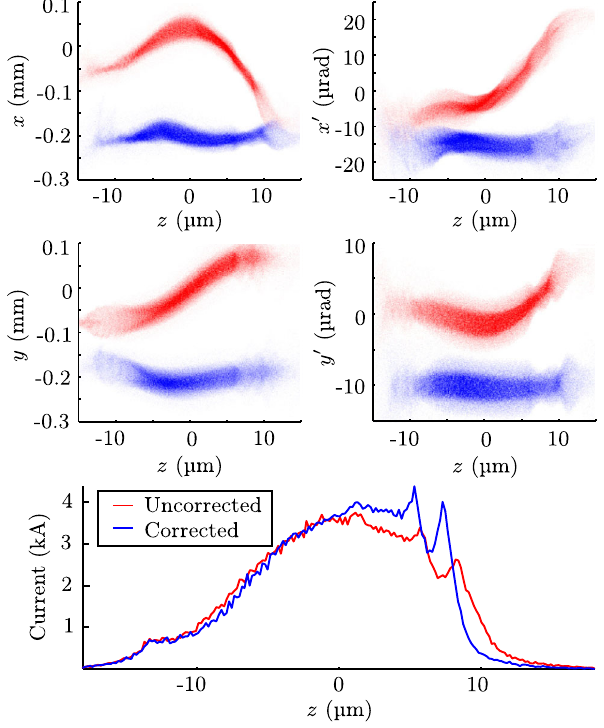
FIG. 7. The four upper plots show the uncorrected (red) and corrected (blue) distribution along the bunch. They have a deliberate constant offset to enhance visibility. The lower plot shows the corresponding current